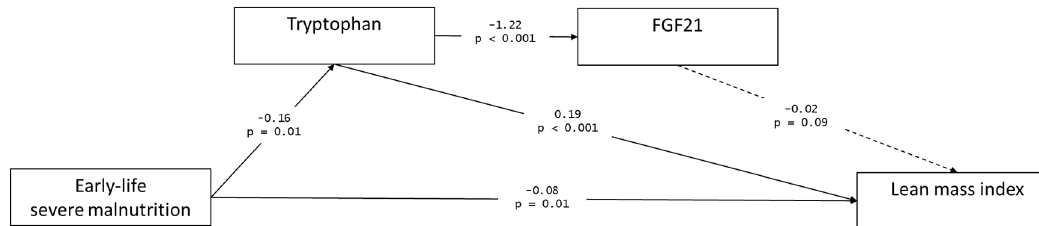
Figure 3. Path analysis of the associations among early-life severe malnutrition (SM), lean mass index, plasma tryptophan and plasma FGF21. Goodness-of-fit indices: root mean squared error of approximation (RMSEA) = 0.06, comparative fit index (CFI) = 0.99, Tucker–Lewis index (TLI) = 0.95. Full arrows are statistically significant ( p < 0.05), broken arrow is not statistically significant. Values of arrow represent the association estimate β above and the p -value below. All paths are controlled for age, sex, and HIV status. Full statistical estimates can be found in Supplementary Table 2.